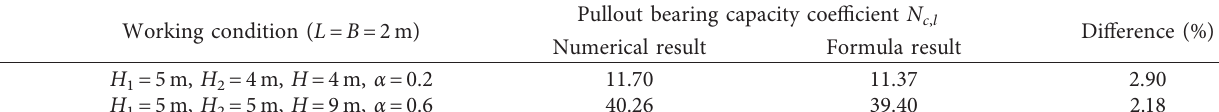
Table 1: Verification of the pullout bearing capacity formula.